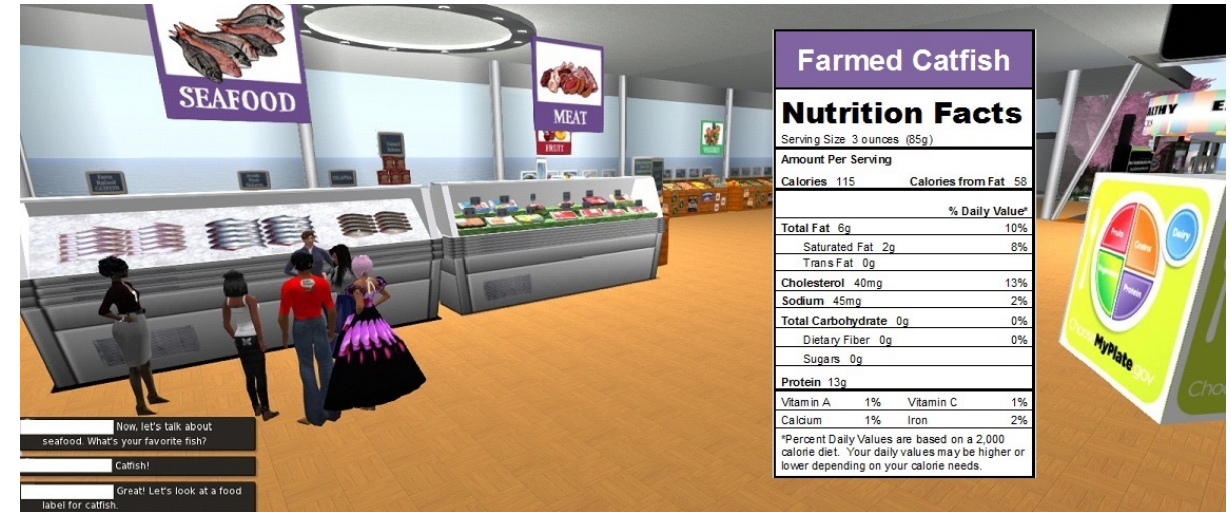
Figure 1. Dietitian-led discussion of reading food labels in the grocery